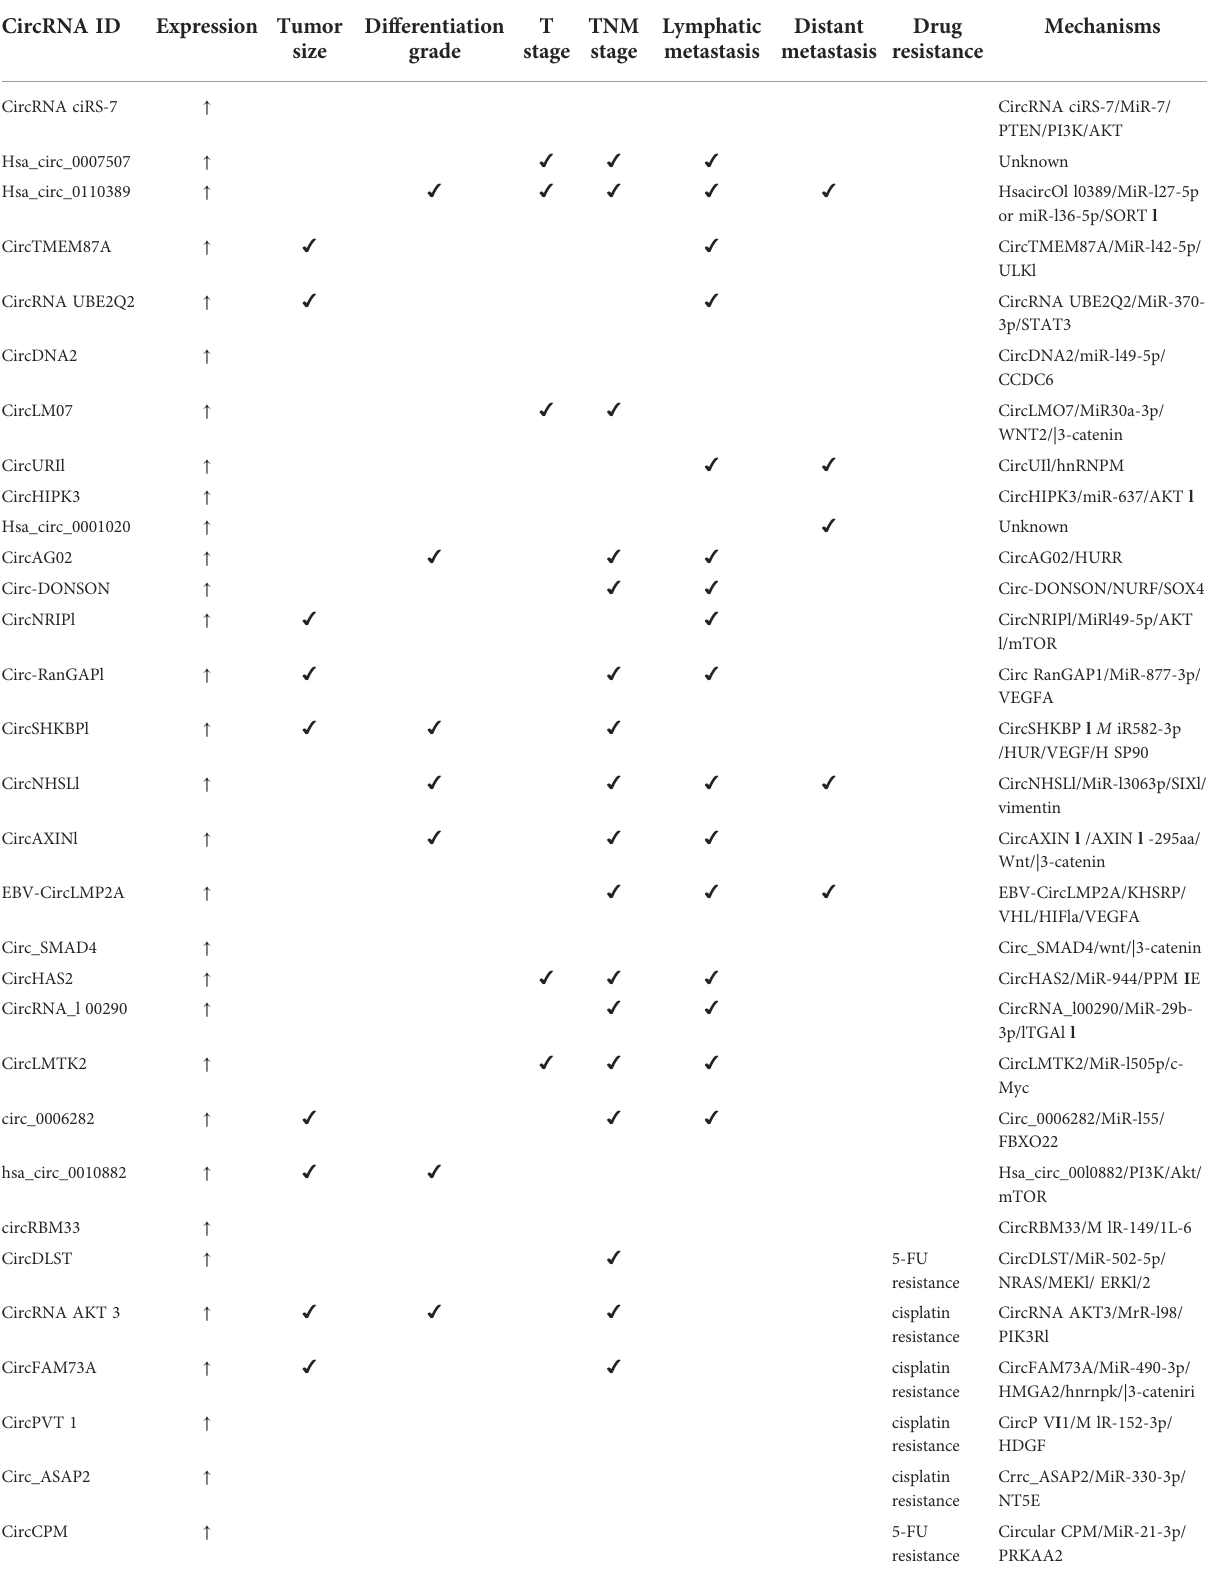
TABLE 1 Summary of some tumor-related